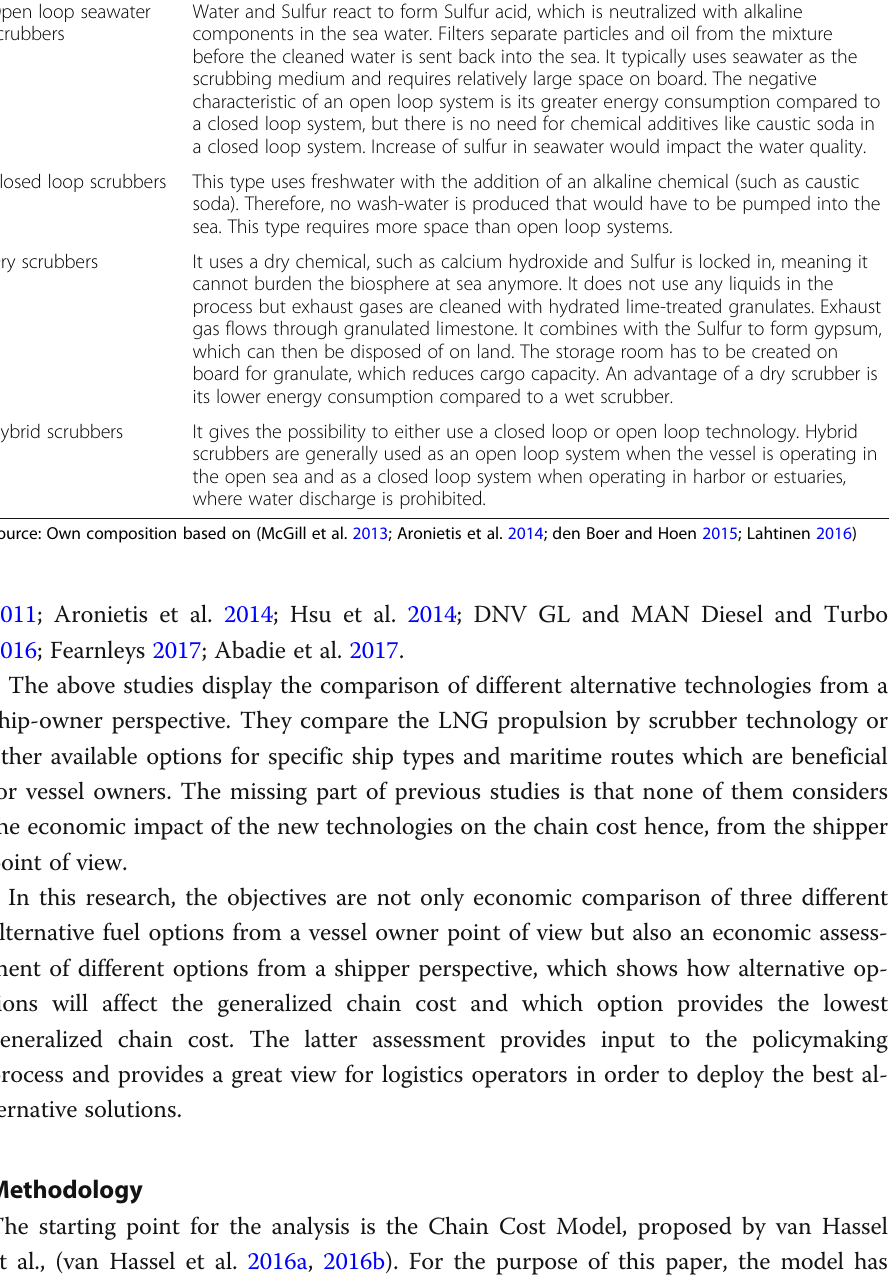
Table 5 Different scrubber systems and relevant features Open loop seawater